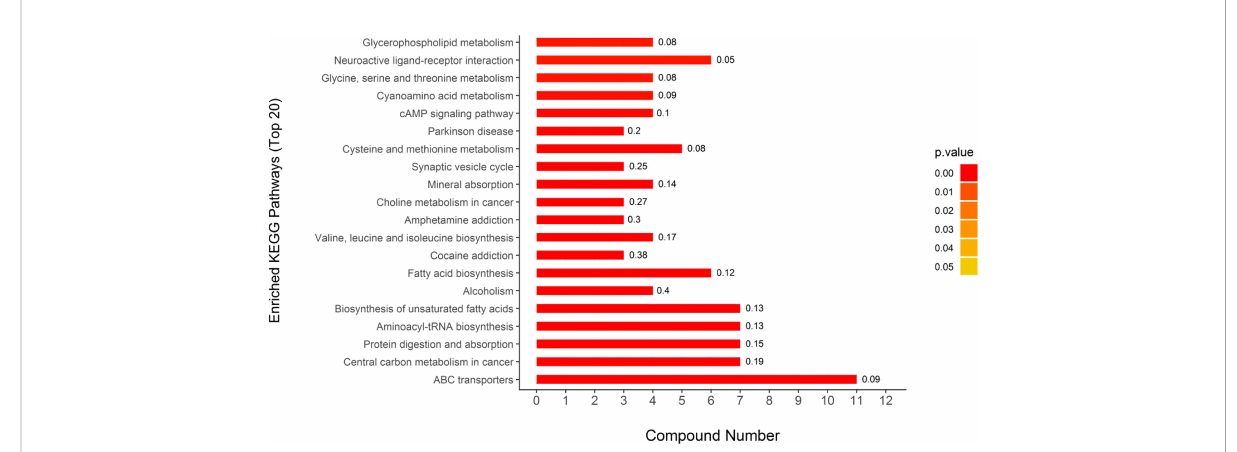
FIGURE 7 KEGG pathway enrichment analysis results of different metabolites. The color bars represent the adjusted p -values calculated using Fisher ’ s exact test in conjunction with Benjamini-Hochberg correction. Rich Factor means the ratio of the number of DEPs to the number of all annotated genes in this KEGG pathway; this is labeled at the top of the bar diagram.